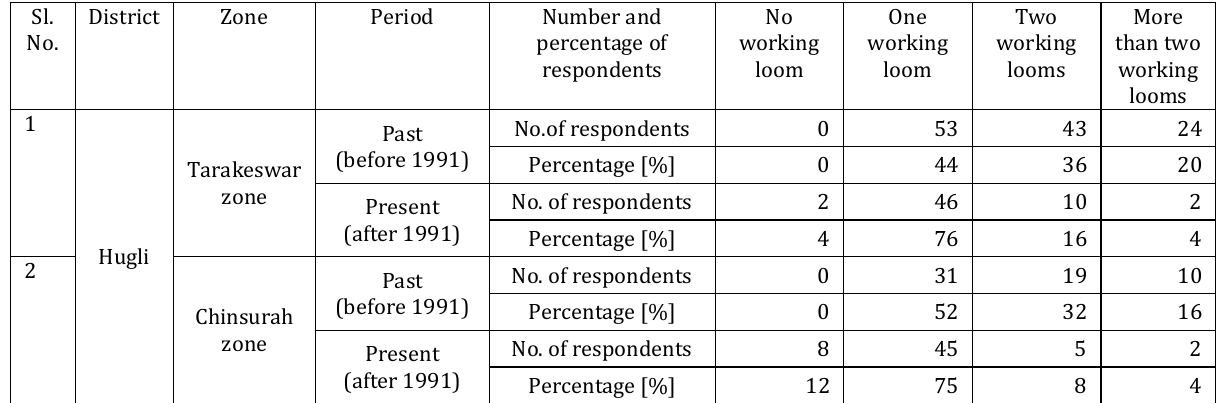
Table 6. Table showing effect of globalisation on weaving asset (n=120) (Source: Primary survey 2017-2018)